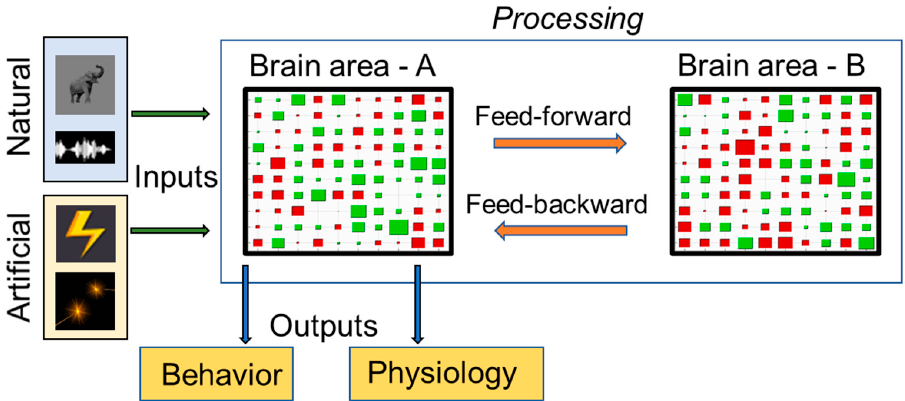
Figure 1. Envisioning Marr’s theoretical framework for characterization of a given brain area (Brain area—A) as a sensory information processing system. At the computational level, the relevance of the processing can be visualized as the system taking in inputs and generating outputs relevant to the organism. The inputs are shown on the extreme left as natural (visual and auditory) and artificial (electrical microsimulation and optogenetic stimulation) stimuli. Outputs are shown as behavioral and physiological manifestations. This framework also considers the relative compositions of areas A and B with 2 subtypes of neurons, that is excitatory (indicated as green rectangles), and inhibitory (indicated as red rectangles). Additionally, at an algorithmic level, processing as shown in the light blue box considers both feed-forward and feed-backward communications and relative firing rates of neurons (indicated with sizes of red and green rectangles).